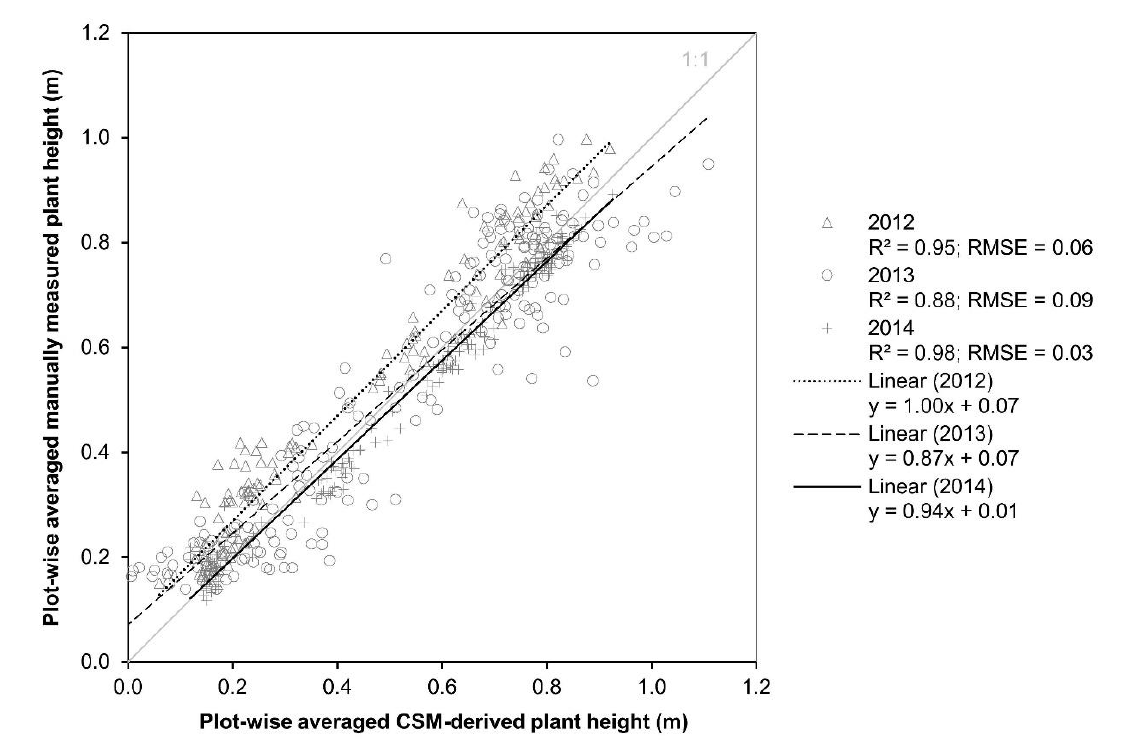
Figure 4. Regression of the mean CSM-derived and manual measured plant heights (2012: n = 131; 2013: n = 196; 2014: n =